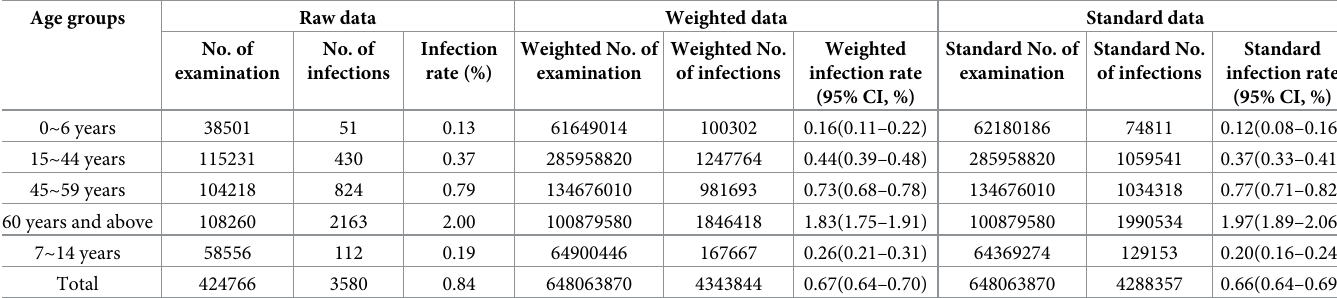
Table 3. Infection rate of hookworm among different age groups in 2019 according to the national surveillance. Age